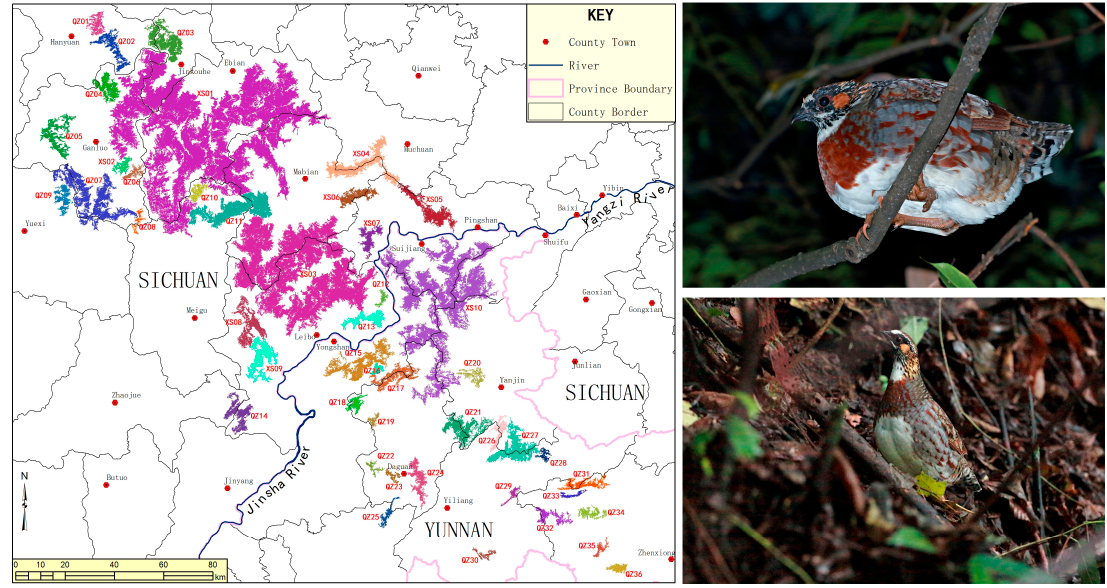
Figure 1. Distribution and photos of the Sichuan partridge.